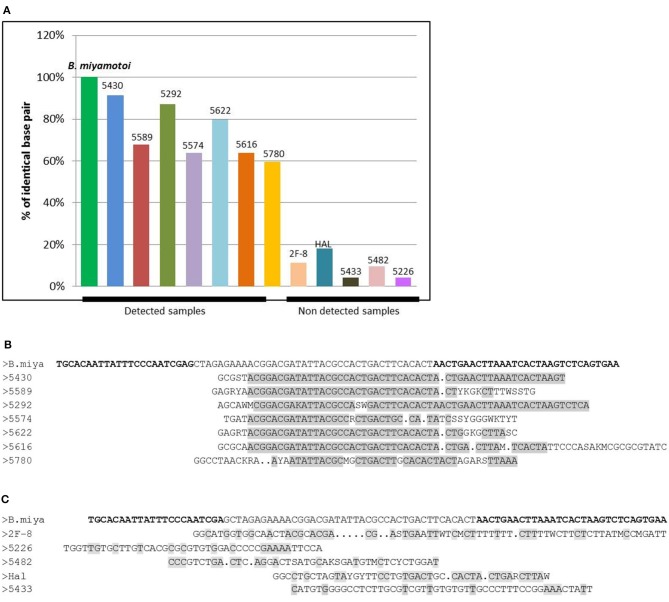
(A) Graph of the percentage of identical base pairs for the detected and undetected samples for B. miyamotoi PCR. The percentage of identical sequenced bases is >60% for the detected samples which display long runs of identical bases (B) and <20% for the samples not detected in PCR with no long runs of identical nucleotides (C). The sequence of interest of B. miyamotoi is a very short sequence (94bp). When sequencing small sequences, the first bases may not be recognized by the sequencer because of the brevity of the sequence, which explains why for some positive samples, sequencing only returns 60% of the bases of the sequence.